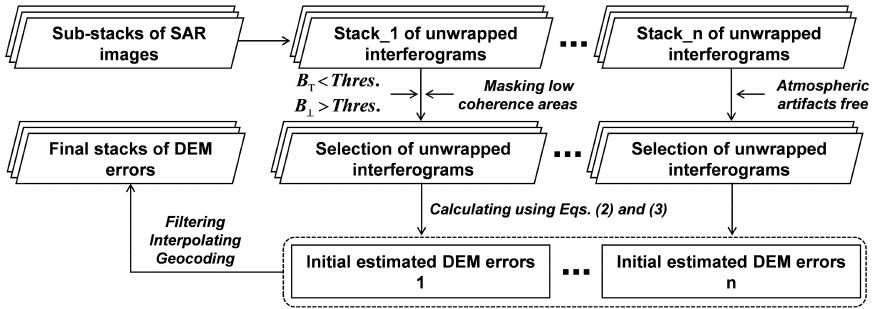
Figure 4. Flowchart of dynamic estimation of DEM errors, where Thres. indicates the threshold, and Eqs. represents the